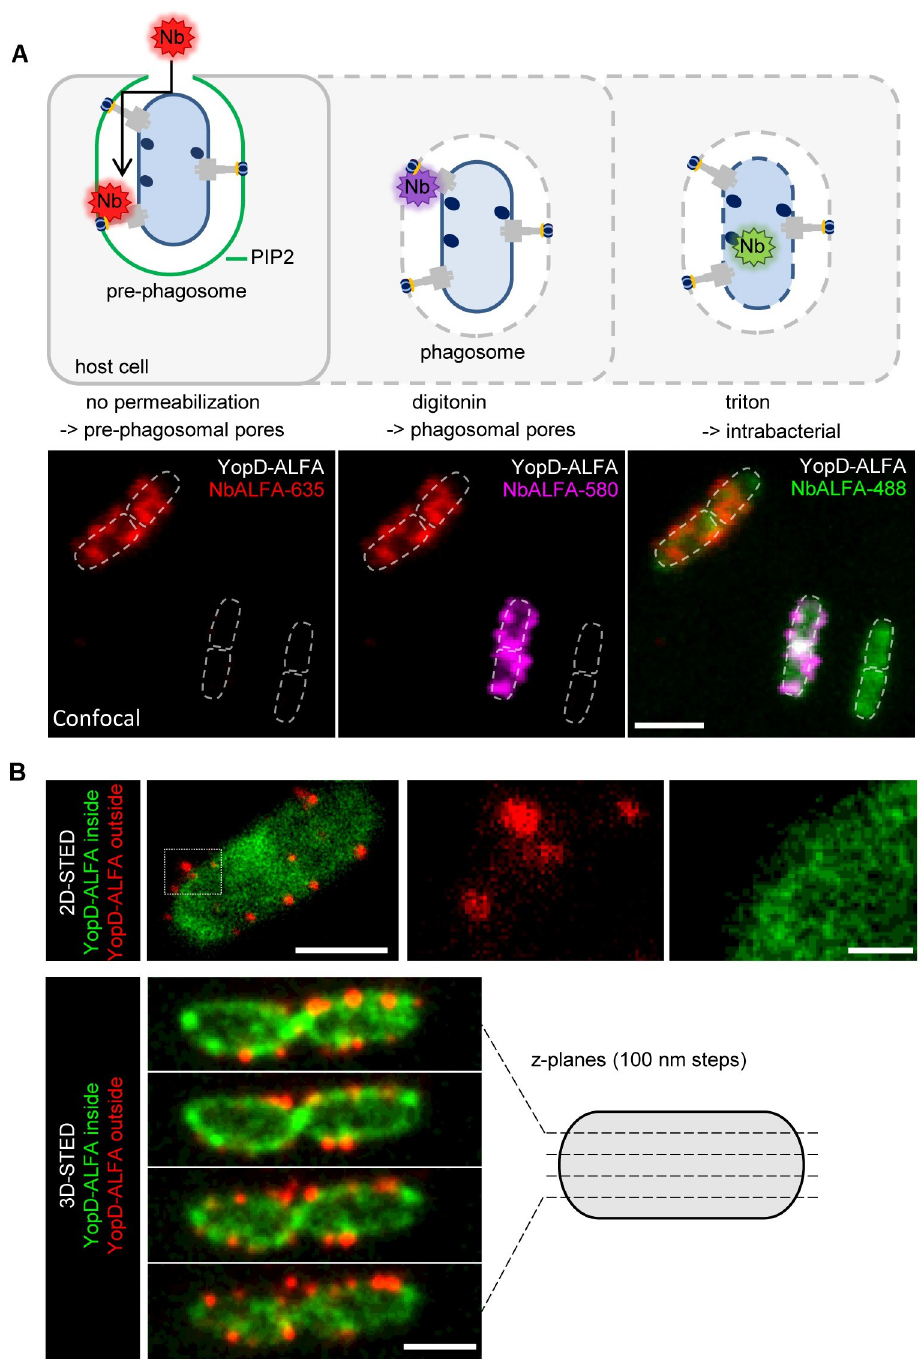
Fig 2. Differential permeabilization for selective staining of YopD-ALFA in different cellular compartments. (A) Selective nanobody staining of YopD-ALFA in different cellular compartments. The schematic (top) shows different levels of host- and bacterial cell permeabilization and according accessibility of different pools of YopD-ALFA for NbALFA staining. Rac1Q61L expressing HeLa cells were infected with WA-314 YopD-ALFA at an MOI of 10 for 1 h, fixed and stained with NbALFA-635 without prior permeabilization to specifically target translocon associated YopD-ALFA in the pre-phagosomal compartment (left, shown in red). Host cell membranes were permeabilized with digitonin and translocons located in closed phagosomes were stained with NbALFA-580 (middle, shown in magenta). Note that pre-phagosomal YopD-ALFA was already saturated with NbALFA-635 (red) during the first staining step. Finally, also the bacterial membranes were permeabilized with triton and the intrabacterial pool of YopD-ALFA was